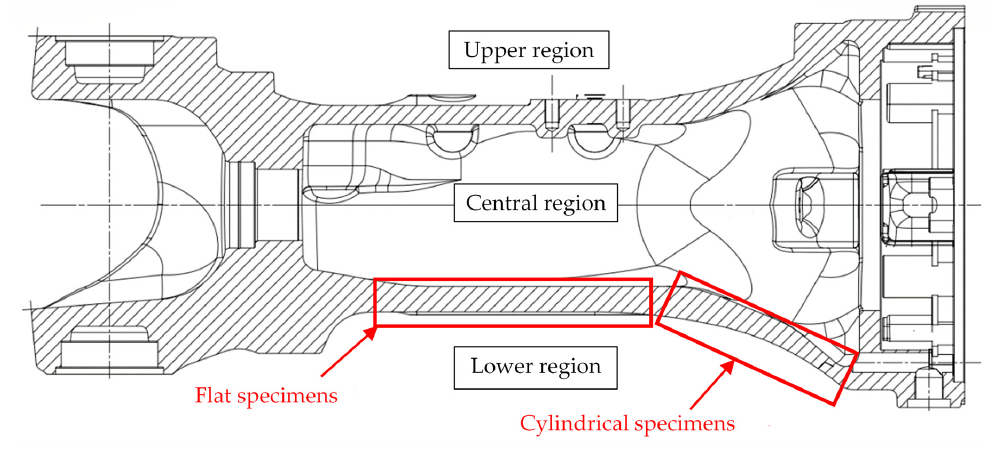
Figure 1. Regions of the axle where samples were taken.